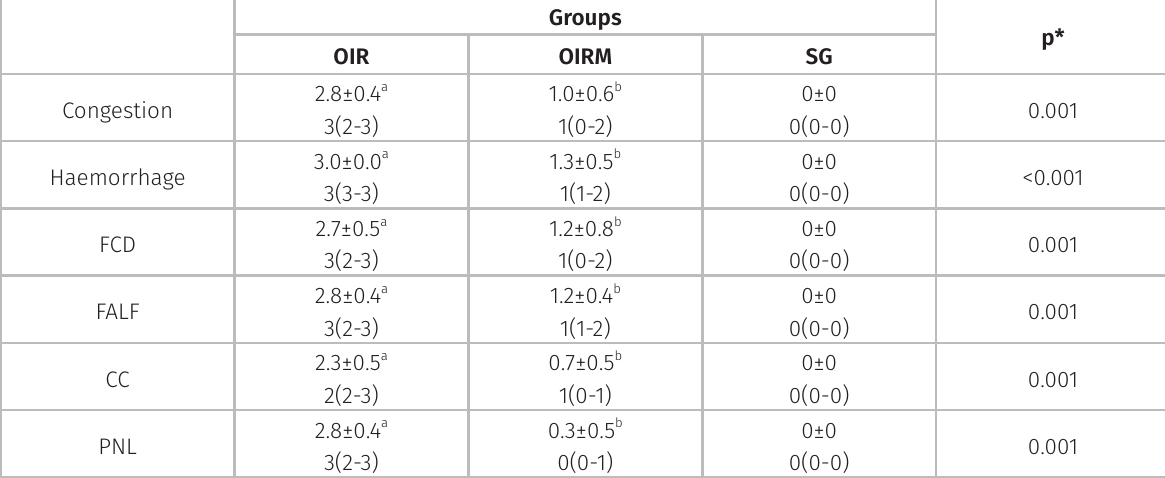
Table II. Histopathological assessment in study groups.